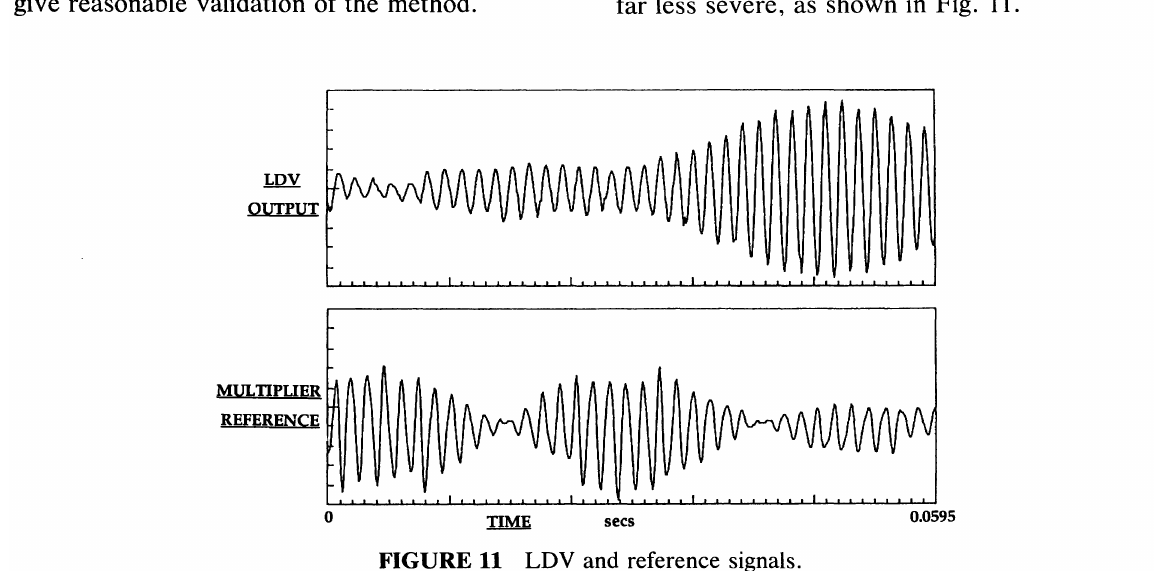
FIGURE 11 LDV and reference